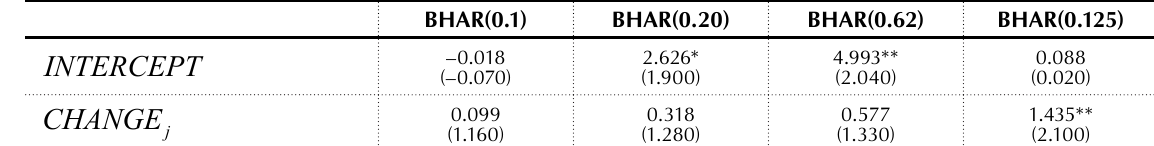
Table 4. Ambiguity and BHARs: controlling for